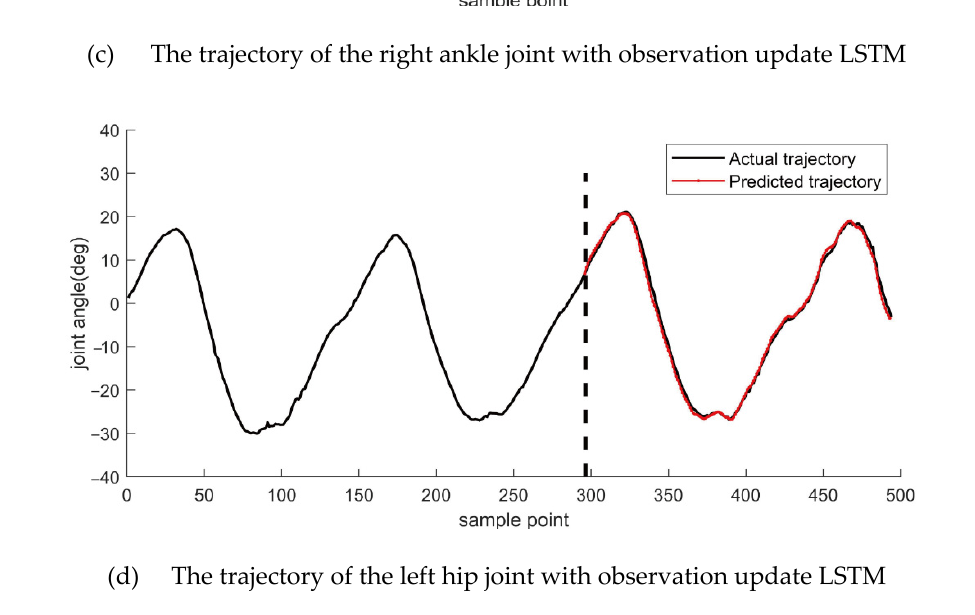
The trajectory of the left hip joint with observation update LSTM